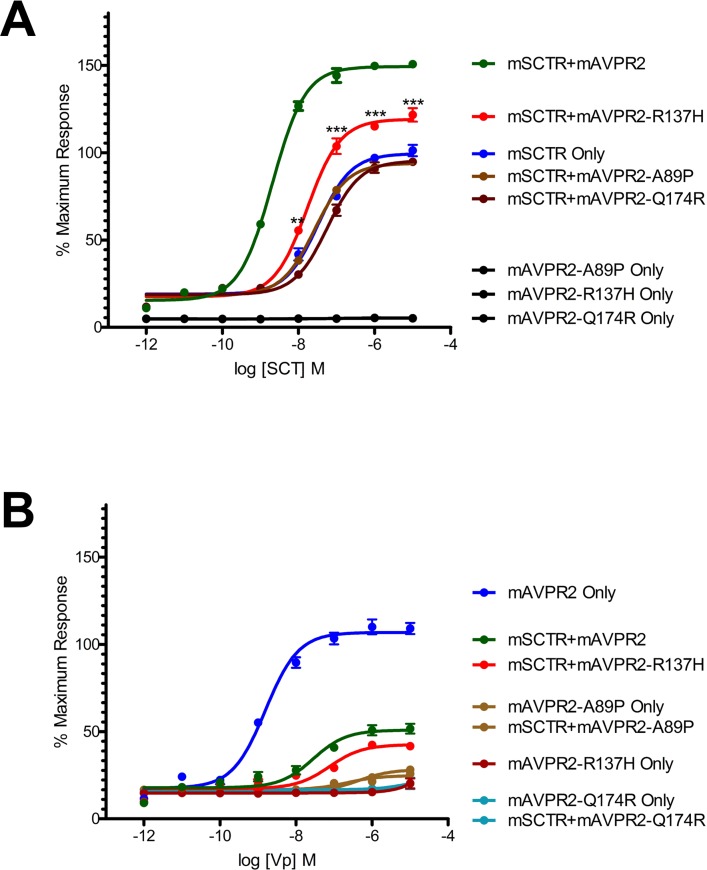
mSCTR-rescued mAVPR2-R137H functions similarly to WT receptor.In both SCT (panel A) and Vp (panel B) events, mSCTR was able to rescue the functioning of the mutated mAVPR2-R137H. Aligned with WT AVPR2, rescued AVPR2 mutant could potentiate SCT-induced cAMP. Note that although oligomer formation restores Vp’s ability in stimulating the R137H receptor, the effect of oligomer formation blunting cAMP response elicited by Vp was still in place. The data were mean±SEM from three to five independent experiments in triplicate. ***, P<0.001. **, P<0.01.